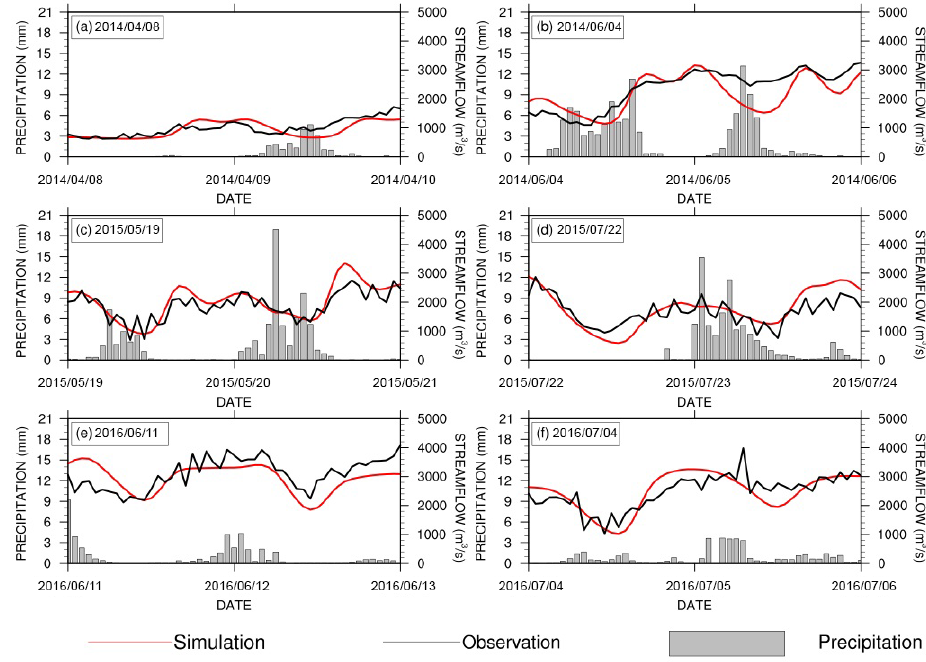
Figure 5. The same as Fig. 4 but for the evaluation of hourly streamflow simulations at the Yantan hydrological gauge. (Please note that dates are given in the following format in this figure: